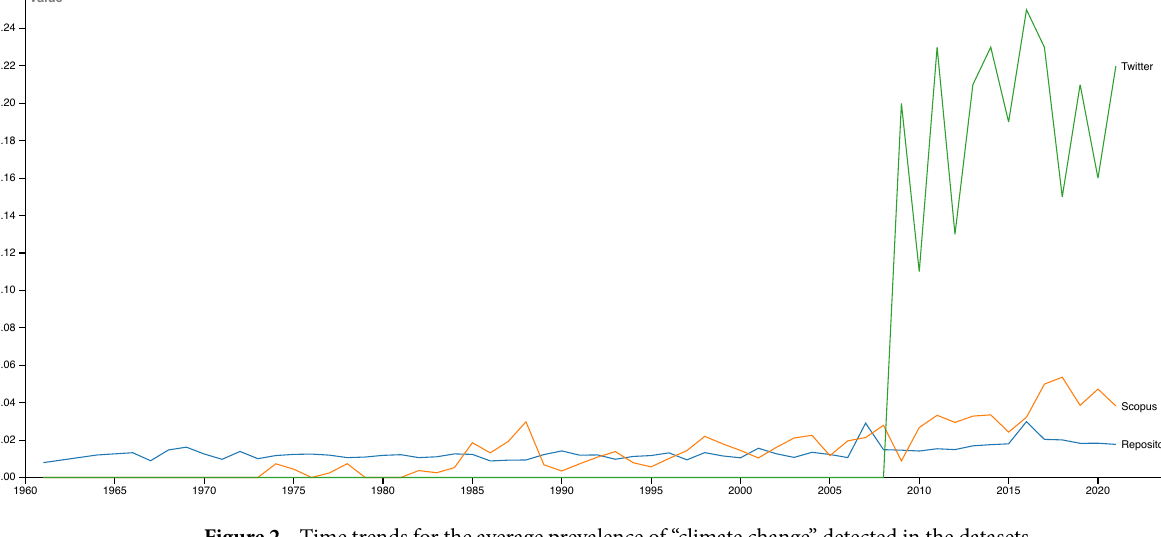
Figure 2. Time trends for the average prevalence of “climate change” detected in the